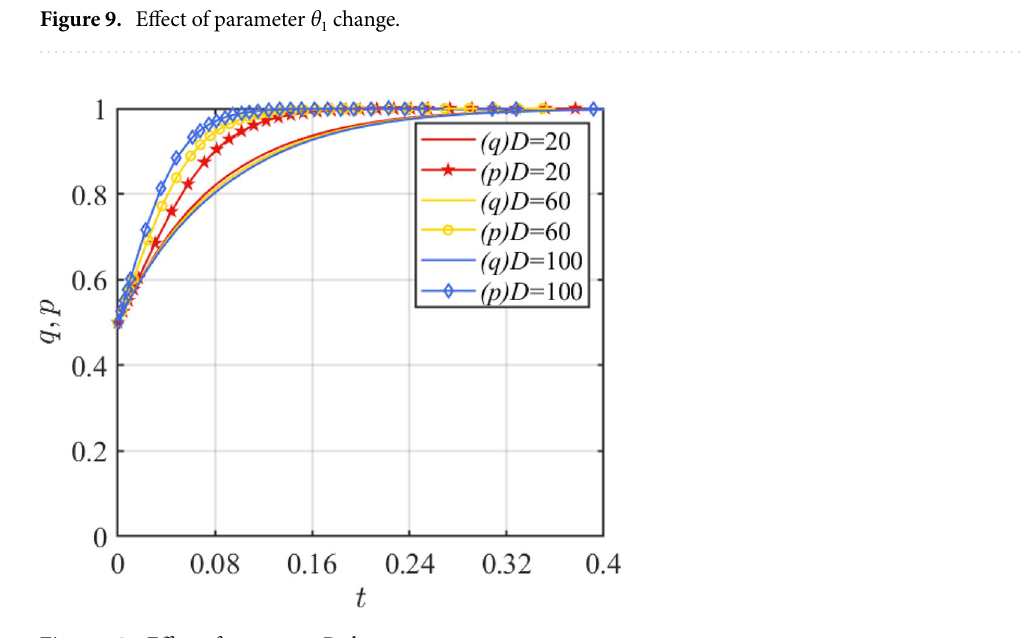
Figure 10. Effect of parameter D